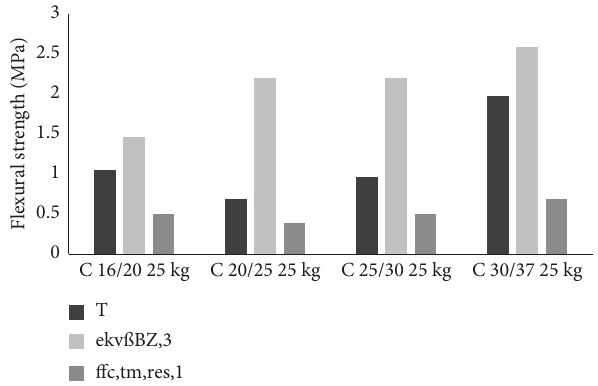
Figure 8: Residual tensile strength in bending at the moment of achieving a deflection of 3.5mm, steel fiber reinforced concrete with a dose weight of 25kg/m 3 .